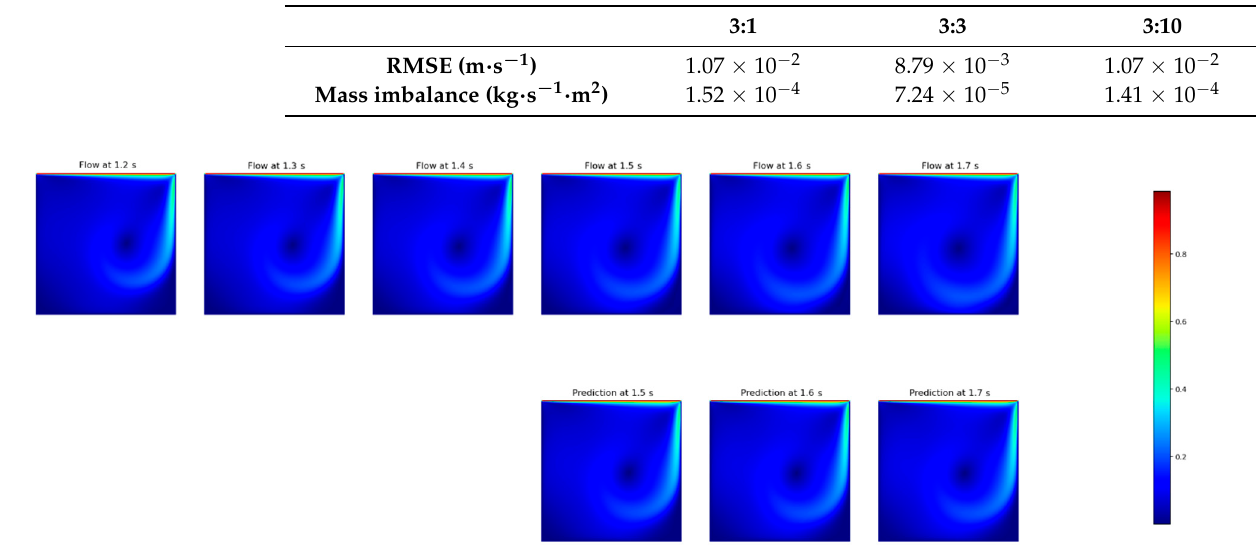
Table 6. FNO testing errors for predicting several timesteps in advance, for three input time window sizes, after a maximum of 300 epochs.